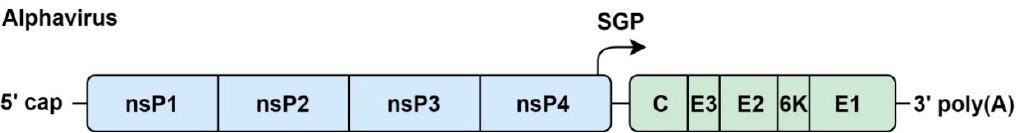
Figure 3. Genome organization of alphaviruses. The genome encodes two ORFs, which contain the four nonstructural proteins (nsP) and the structural proteins (C, capsid; E, envelope). The structural proteins are expressed from a subgenomic promoter (SGP). Blue and green indicate the nonstructural and structural proteins,